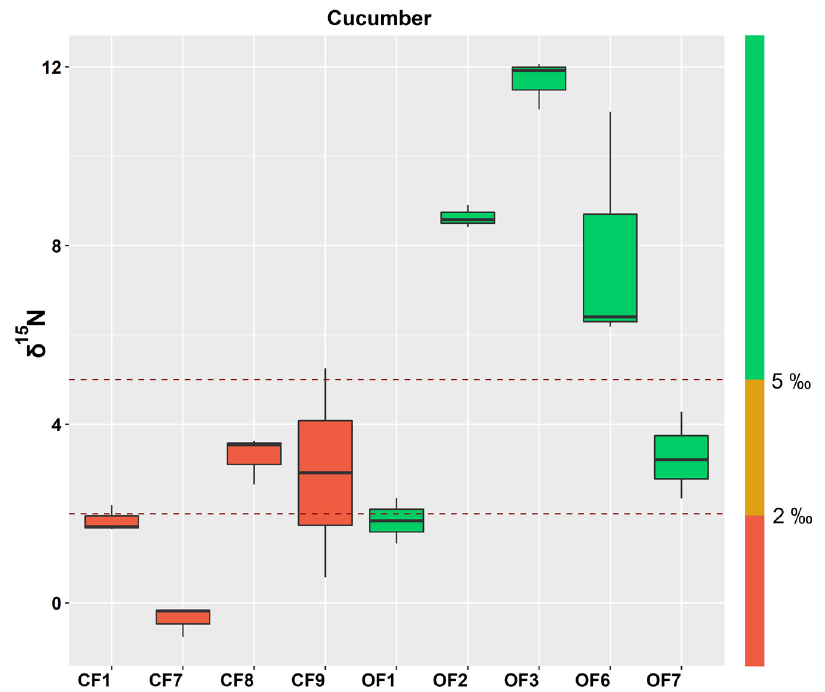
Figure 2. Boxplot of the δ 15 N values measured in cucumber including three operation ranges. The green range (>5‰) indicates good organic practices, the orange range indicates (values between 2–5‰) organic crops that need to be supervised, and the red range (<2‰) indicates conventional crop systems.